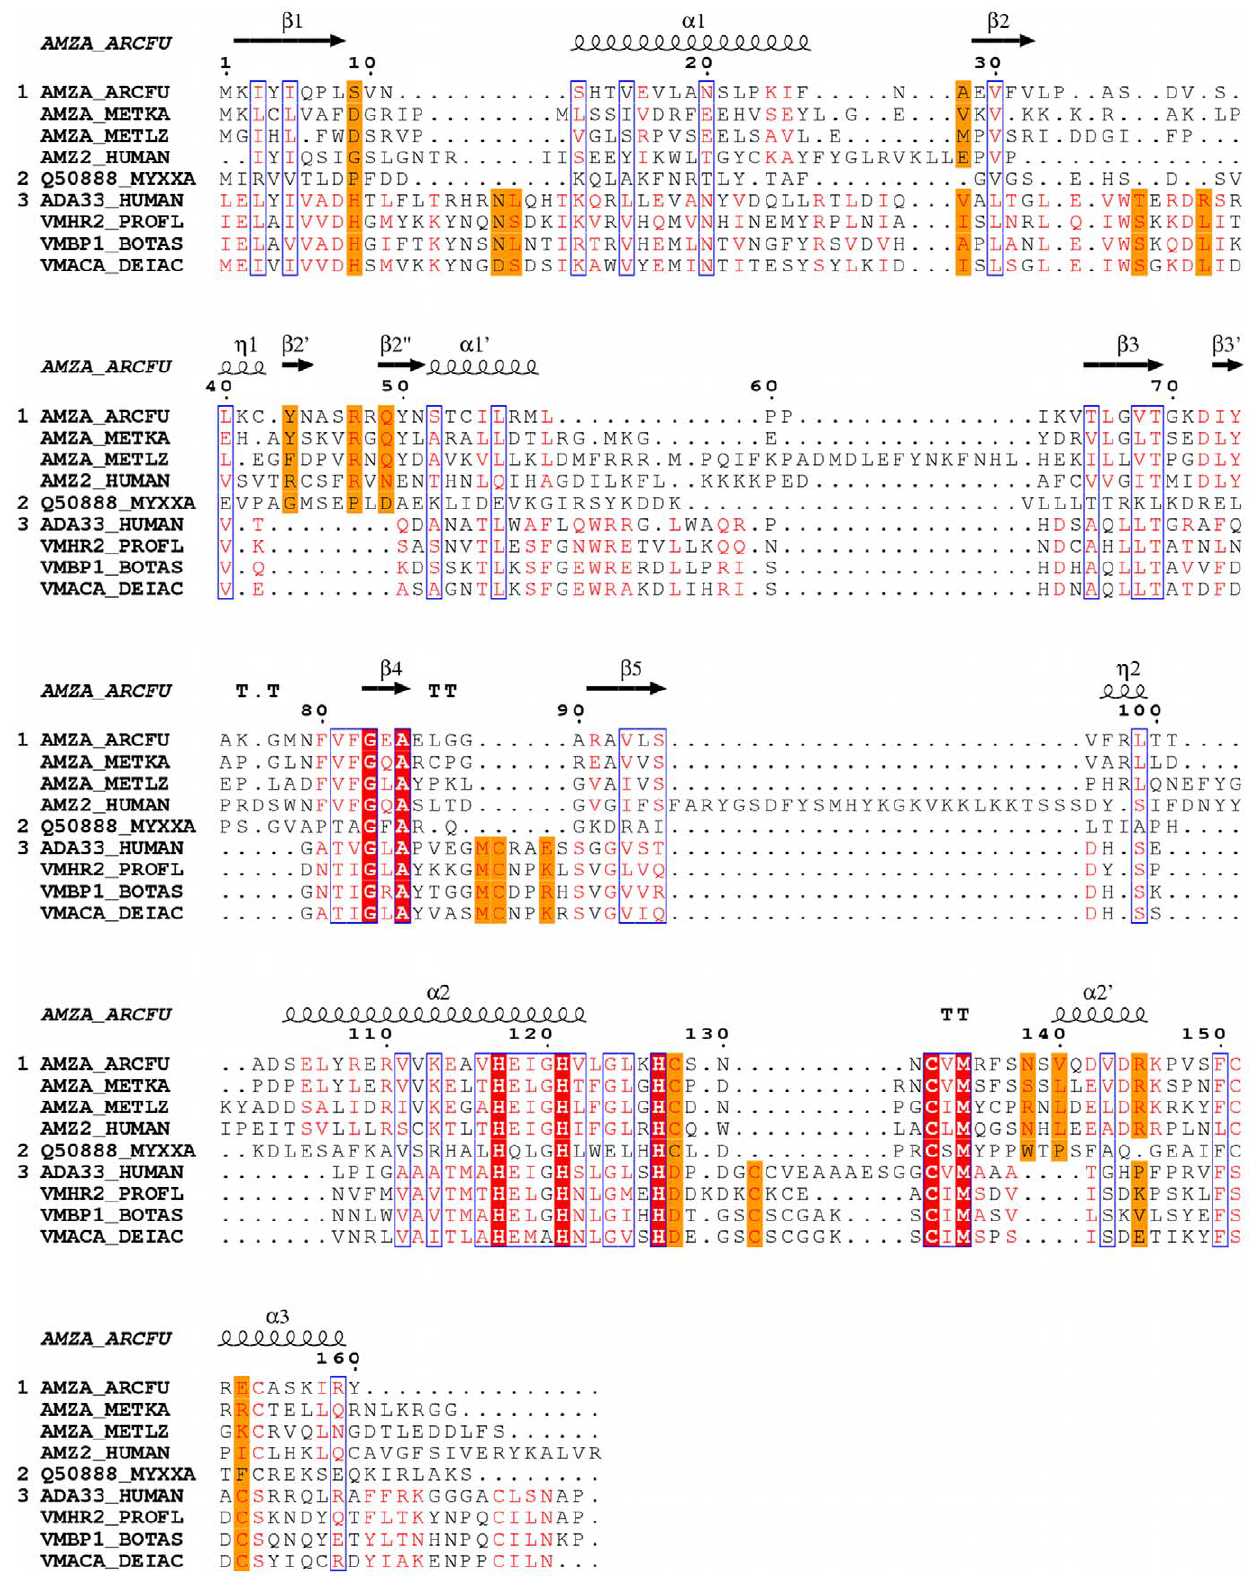
Figure 3. Multiple sequence alignment of the amino acid sequences of Af AmzA with other archaemetzincins and metzincins. Archaemetzincins from M. kandleri (AMZA_METKA), M. labreanum (AMZA_METLZ), H. sapiens (AMZ2_HUMAN), non-catalytic archaemetzincin from M. xanthus (Q50888_MYXXA) and metzincins H. sapiens ADAM33 (ADA33_HUMAN), P. flavoviridis H2-proteinase (VMHR2_PROFL), B. asper Bap1